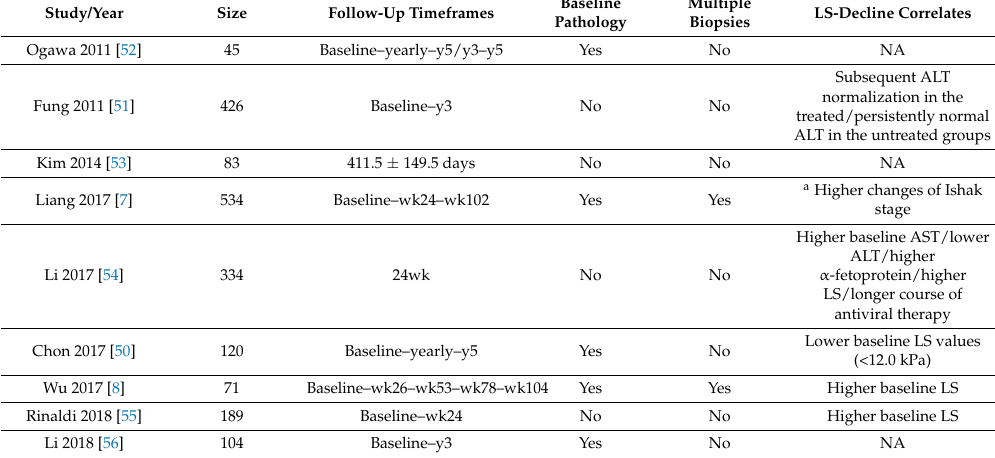
Table 2. Published studies on liver stiffness surveillance in patients with chronic hepatitis